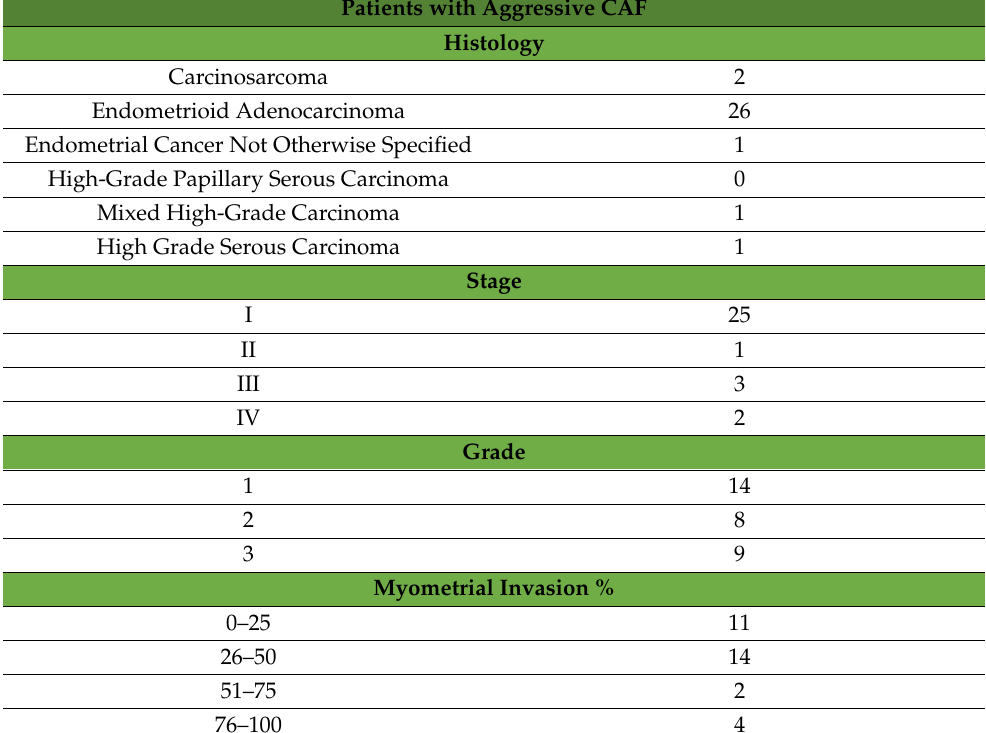
Table 2. Pathological parameters of endometrial cancer patients bearing aggressive and non- aggressive